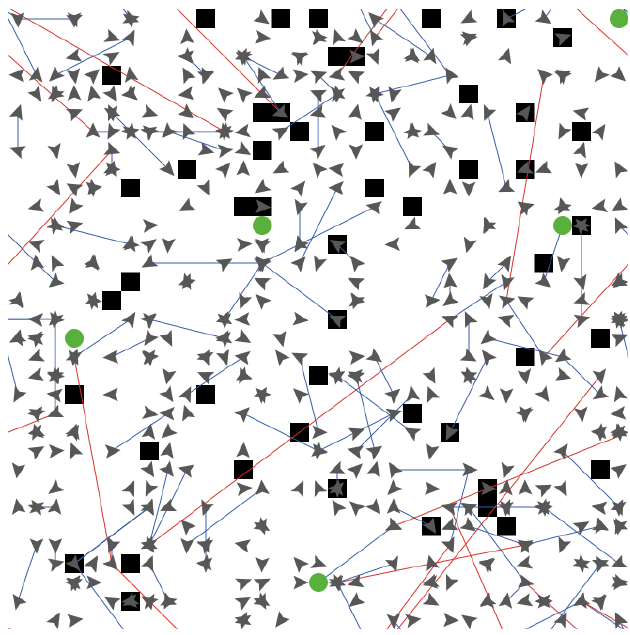
Figure 6. A Sample Setup of Connectivity Network, where blue and red colors are used to show local and remote